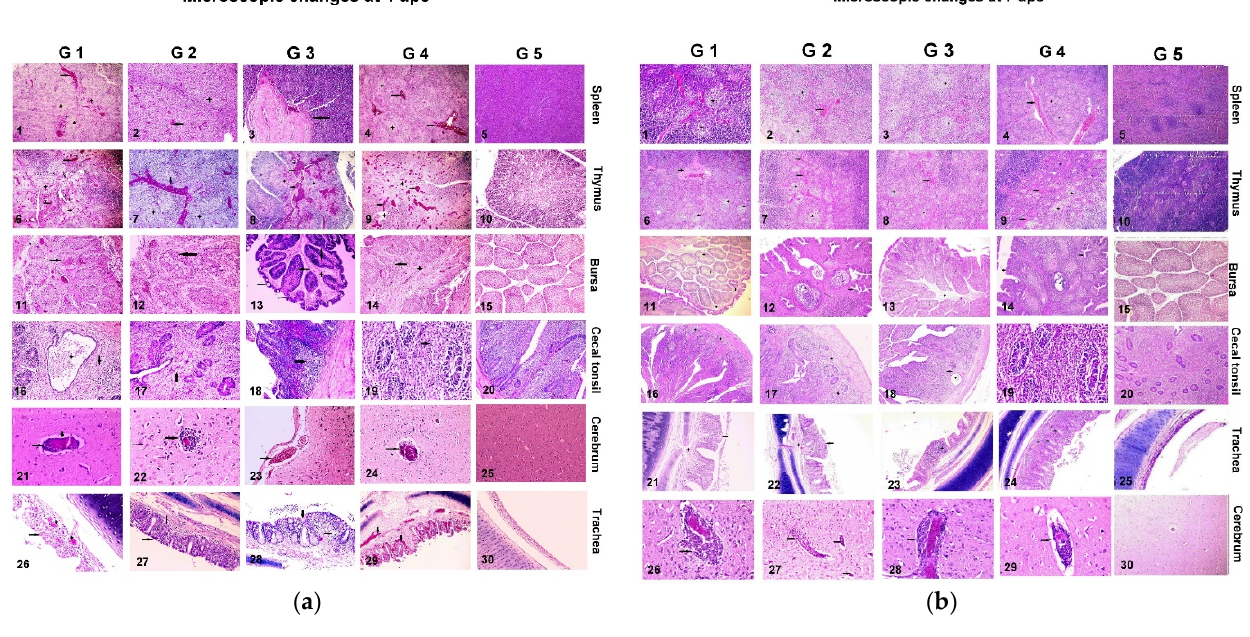
Figure 5. ( a ) 1: Spleen (G-1) showing severe congested blood vessels (arrow), hemorrhage, and lymphocyte depletion (50 × ). 2: Spleen (G-2) showing severe lymphocyte depletion (star), conges- tion, and hemorrhage (arrow) (50 × ). 3: Spleen (G-3) showing thickening of the blood vessel walls (arrow) (100 × ). 4: Spleen (G-4) showing congested blood vessels (arrow) and lymphocyte depletion (star) (50 × ). 5: Spleen (G-5) showing apparently normal structures (H&E 100 × ). 6: Thymus (G-1) showing severe depletion, lymphocyte necrosis (star), and congested blood vessels (arrow) (H&E 50 × ).7: Thymus (G-2) showing thymocyte depletion (star) with congestion of blood vessels (arrow) (H&E 50 × ). 8: Thymus (G-3) showing severe thymocyte depletion (star) with severe congestion and hemorrhage (arrow) (H&E 50 × ). 9: Thymus (G-4) showing congested blood vessels (arrow) (H&E 100 × ).10: Thymus (G-5) showing apparently normal structures (H&E 100 × ). 11: Bursa (G-1) showing severe lymphocyte depletion and degeneration (arrow) with interfollicular congestion (line) and connective tissue proliferation (star) (H&E 100 × ). 12: Bursa (G-2) showing severe lymphocyte depletion in cortex and medulla (arrow) with interfollicular congested blood vessels (line) (H&E 200 × ). 13: Bursa (G-3) showing hyperplasia of epithelium lining with cystic formation (line) and lymphocyte depletion in the medulla (arrow) with interfollicular edema (star) (H&E 100 × ). 14: Bursa (G-4) showing lymphocyte depletion (arrow) in medulla of follicles, congested blood vessels with microcysts formation, and interfollicular connective tissue proliferation (star) (H&E 100 × ). 15: Bursa (G-5) showing apparently normal structures (H&E 100 × ). 16: Cecal tonsil (G-1) showing cystic crypt containing necrotic debris (star) with lymphocyte depletion (arrow) (H&E 200 × ). 17: Cecal (G-2) showing depletion and lymphocyte necrosis (arrow) (200 × ). 12: Cecal tonsil (G-3) showing lymphocyte depletion (arrow) (H&E 200 × ). 12: Cecal tonsil (G-3) showing lymphocyte depletion (H&E arrow) (200 × ). 19: Cecal tonsil (G-4) showing lymphocyte depletion and necrosis (arrow) (H&E 400 × ). 20: Cecal tonsil (G-5) showing apparently normal structures (H&E 100 × ). 21: Cerebrum (G-1) showing lymphocytic perivascular cuffs (arrow) (H&E 400 × ). 22: Cerebrum (G-2) showing lympho- cytic perivascular cuffs with perivascular edema (arrow) and neuronal degeneration (line) (400 × ). 23: Cerebrum (G-3) showing submeningeal congested blood vessels (arrow) (200 × ). 24: Cerebrum (G-4) showing perivascular cuff, large, and small blood vessels surrounded by inflammatory cells (200 × ). 25: Cerebrum (G-5) showing apparently normal structures (H&E 100 × ). 26: Trachea (G 10) showing hyperplasia of epithelium lining (arrow) with severe mucosal and submucosal congestion and edema (star) (H&E 100 × ). 27: Trachea (G-2) showing hyperplasia of epithelium lining (thick arrow) with mild congested blood vessels, edema activation of mucous glands, and few